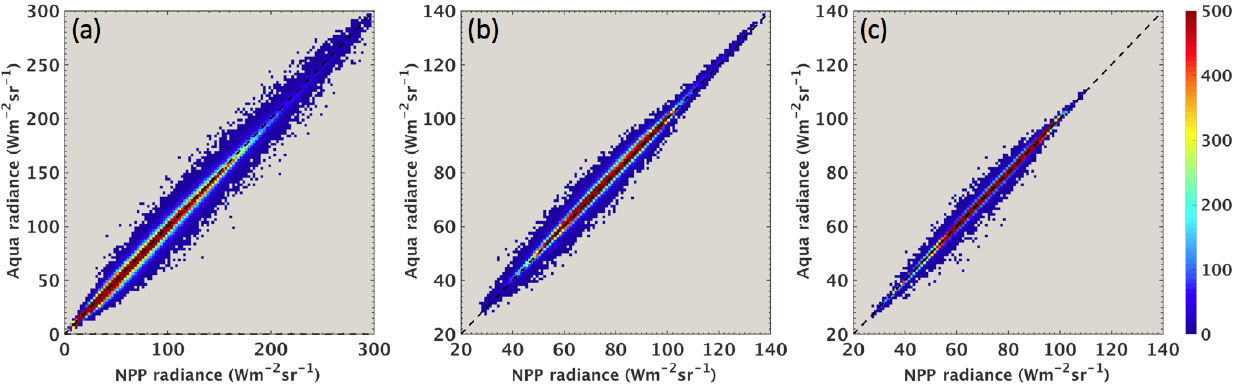
Figure 1. Radiance comparisons between matched Aqua CERES and NPP CERES footprints – (a) SW, (b) daytime LW, and (c) nighttime LW using the data of 2013 and 2014. The total number of footprints, the mean radiances, and the radiance RMS errors are summarized in Table 1. Table 1. Comparison of Aqua-CERES- and NPP-CERES-measured SW, daytime LW, and nighttime LW radiances (Wm − 2 sr − 1 ) and fluxes (Wm − 2 ) using matched footprints of 2013 and